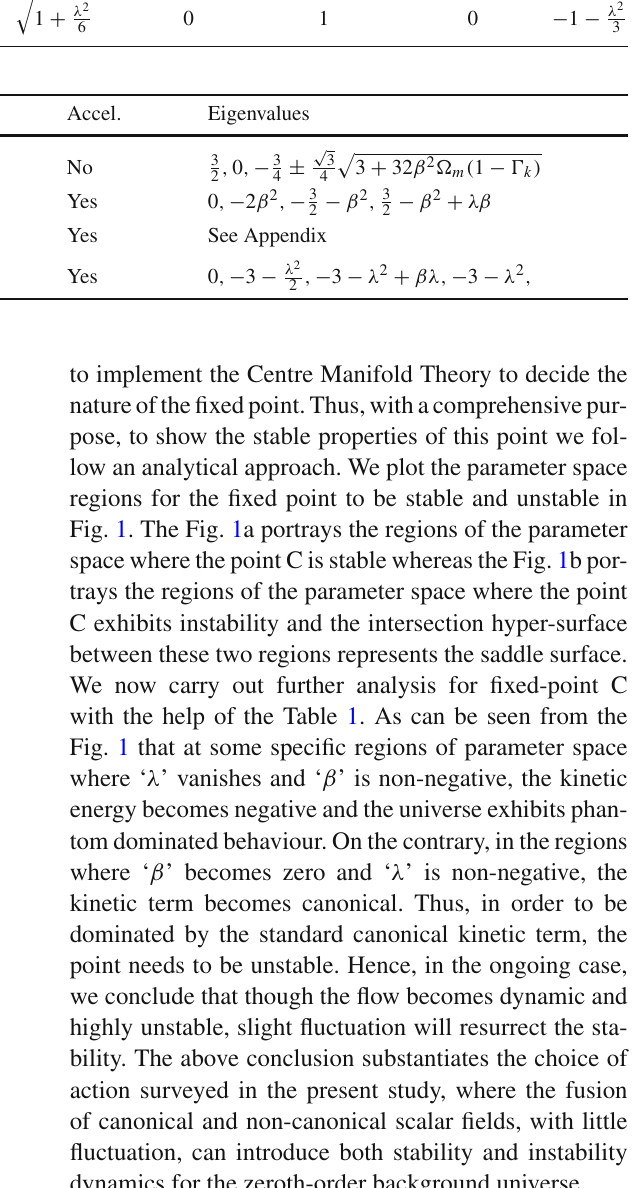
Table 2 The existence and eigenvalues of corresponding critical points